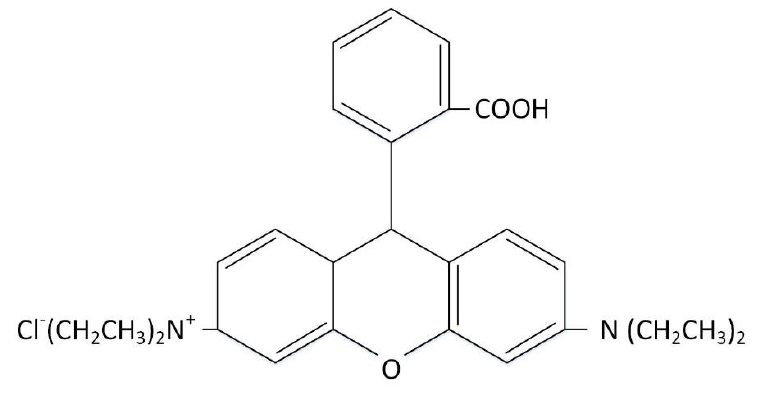
Figure 12. Rhodamine B.